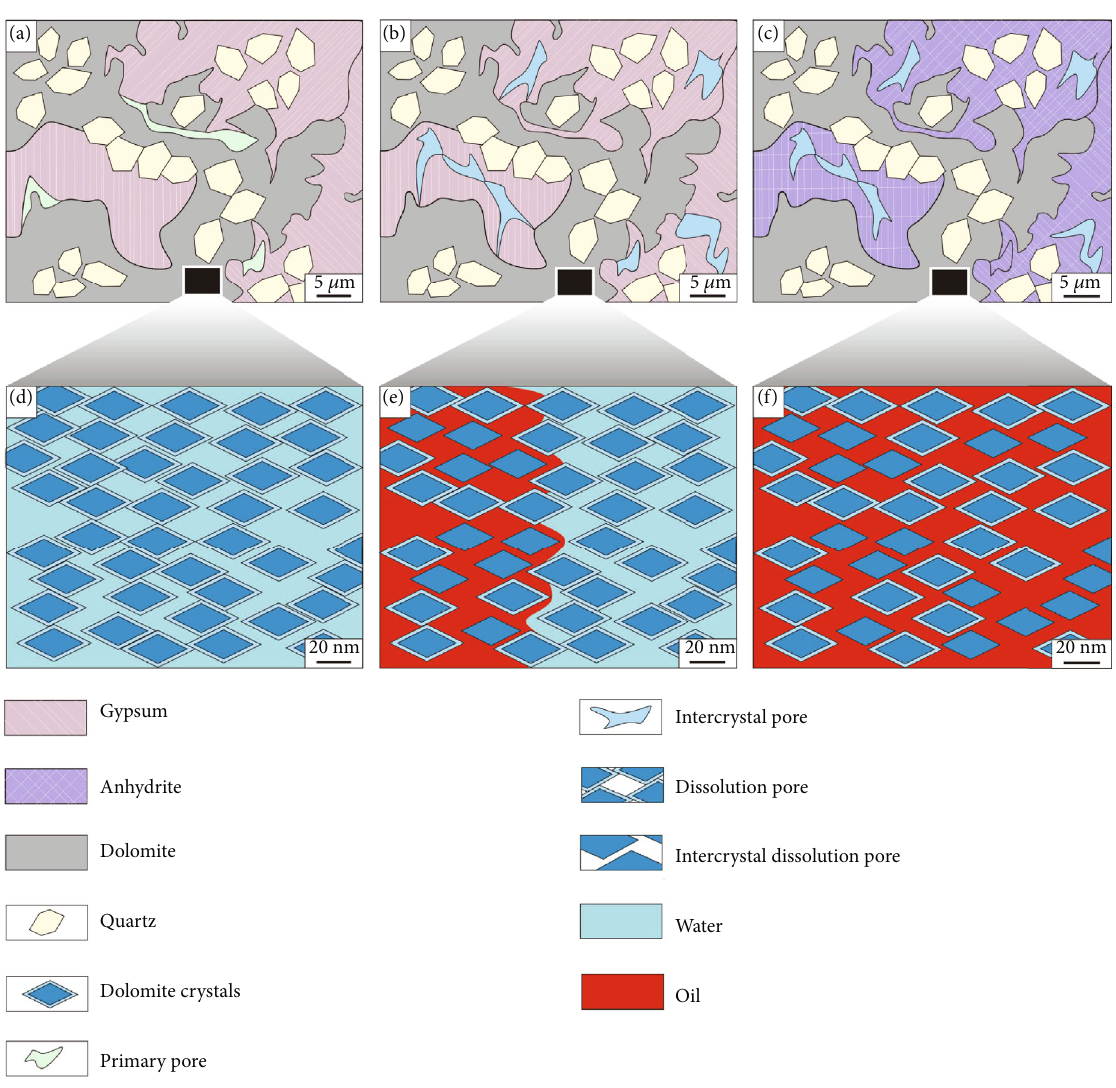
Figure 12: A genetic model for pore structure and connectivity of tight the mixed siliciclastic-carbonate sediment